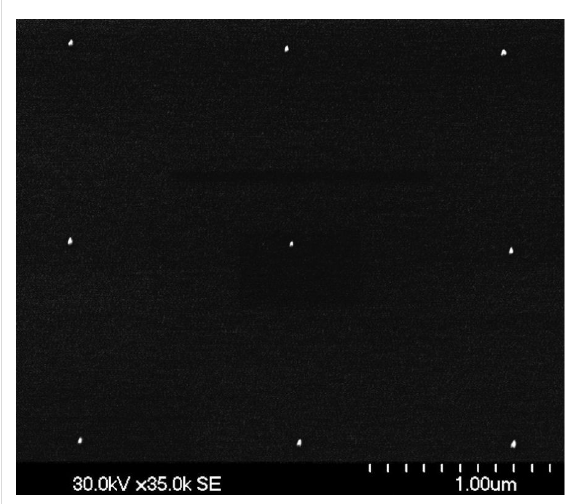
Figure 5: SEM image of four squares of nanopillars as obtained after RIE with single Au NPs, arranged in a square, as etching masks (step 5 in Figure 2). Distance between pillars: 1.2 μ